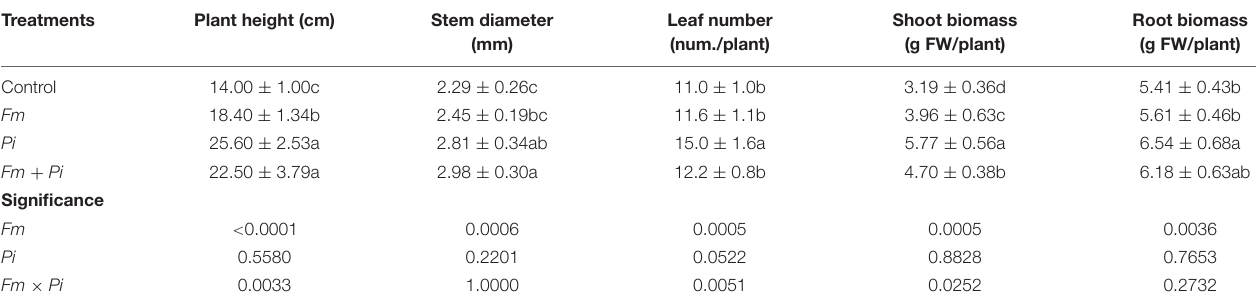
TABLE 2 | Effects of Funneliformis mosseae ( Fm ) and Piriformospora indica ( Pi ) single or in combination on plant growth performance of Polygonum cuspidatum Sieb. et Zucc. Treatments